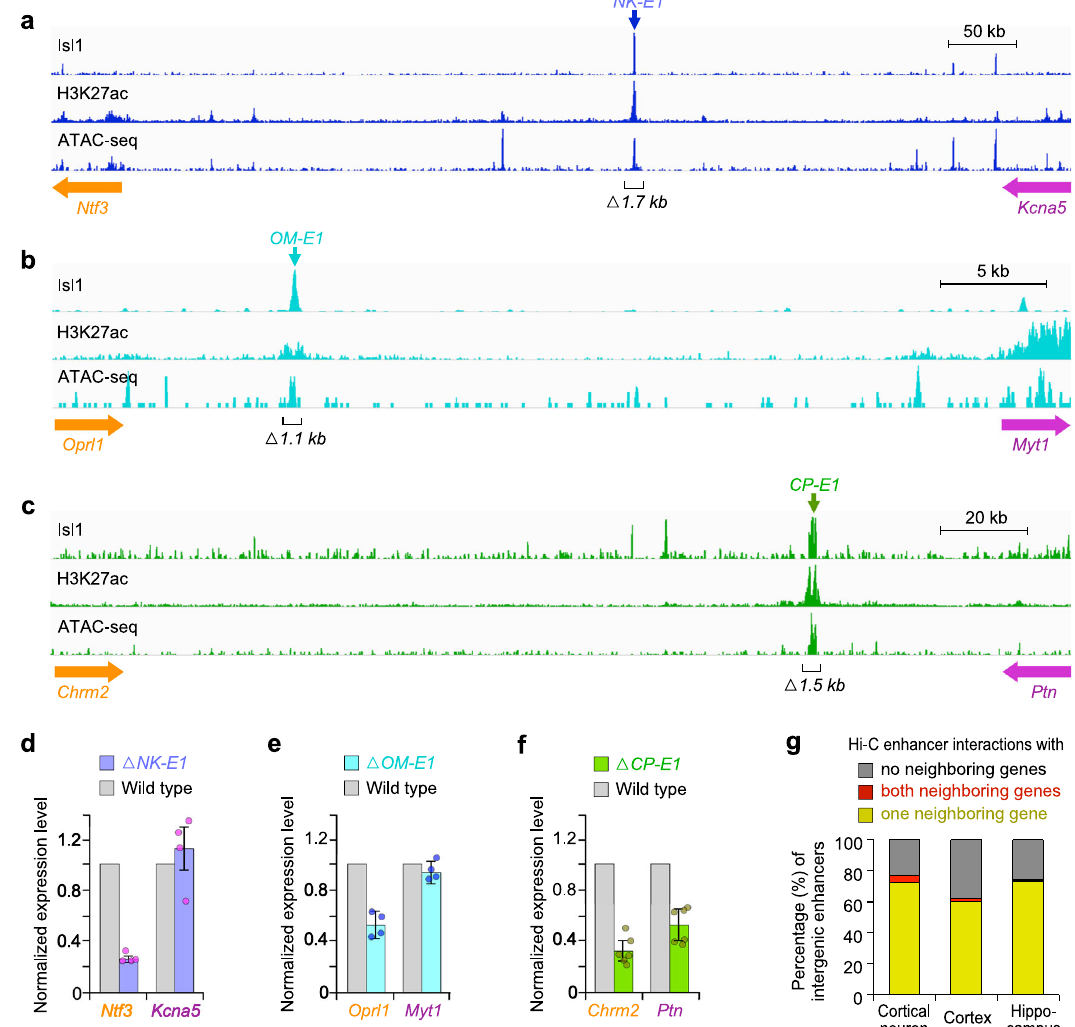
Fig. 7 Intergenic enhancers are necessary for the expression of neighboring neural genes in motor neurons. a The location of Isl1-bound intergenic enhancers, detected by ChIP-seq Isl1, ChIP-seq H3K27ac, and ATAC-seq, located between Ntf3 and Kcna5 genes in motor neurons differentiated from mouse ES cells. 1719 bp genomic DNA of motor neuron-speci fi c NK-E1 enhancer (blue arrow) was deleted in an ES cell using CRISPR genome editing. b , c Same as ( a ) except OM-E1 (cyan arrow) and CP-E1 (green arrow) enhancers that are located in the intergenic regions between Oprl1 and Myt1 , and Chrm2 and Ptn genes, respectively. 1109 bp of OM-E1 and 1468 bp of CP-E1 enhancers were deleted. d Expression levels of neighboring genes, Ntf3 and Kcna5 , measured by quantitative RT-PCR in motor neurons containing the NK-E1 enhancer deletion, normalized to wild type expression levels of Ntf3 and Kcna5 . Error bars represent standard deviation (SD). Data are presented as mean values + / − SD. Dots represent the corresponding data points (Supplementary Data 14). Two biologically independent differentiated cells were examined over 2 independent experiments ( n = 4). e Same as ( d ) except expression levels of Oprl1 and Myt1 genes for OM-E1 enhancer deletion. Two biologically independent differentiated cells were examined over 2 independent experiments ( n = 4). f Same as ( d ) except expression levels of Chrm2 and Ptn genes for CP-E1 enhancer deletion. Two biologically independent differentiated cells were examined over 3 independent experiments ( n = 6). g Percentage of intergenic enhancers interacting with the promoters of the neighboring genes detected by Hi-C. The number of interactions between enhancers and promoters in the mouse cortical neurons, human cortex, and hippocampus was shown in Supplementary Table 1 and Data